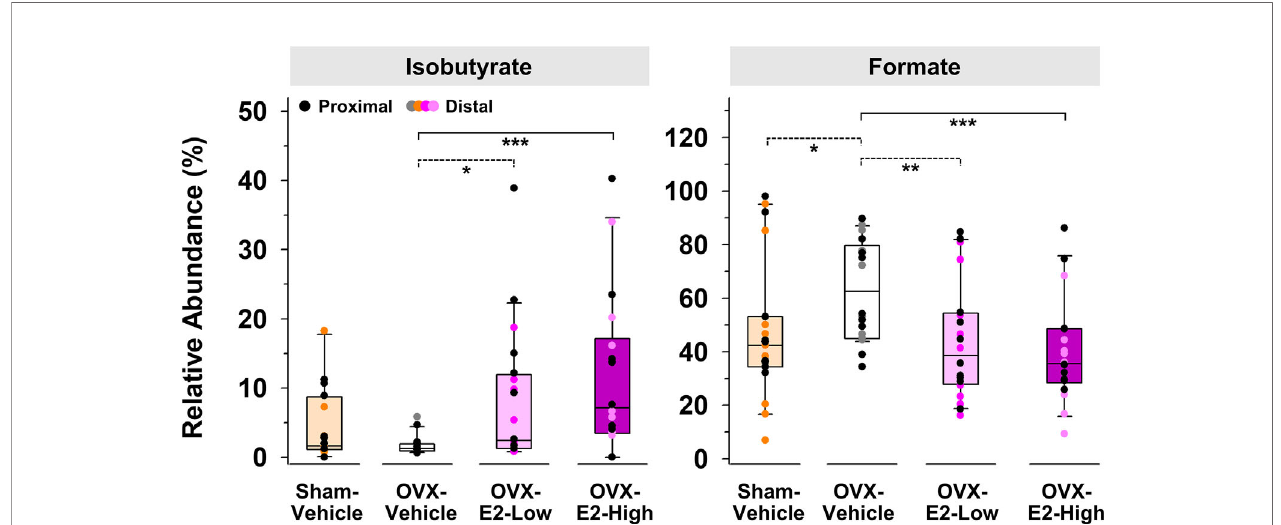
FIGURE 2 | Short-chain fatty acids that displayed a signi fi cantly (LEfSe) higher or lower relative abundance in OVX-E2-Low or OVX-E2-High rats compared to OVX- Vehicle rats. The asterisks indicate statistically signi fi cant differences (*p ≤ 0.05; **p ≤ 0.01; ***p ≤ 0.001). Solid lines between groups indicate signi fi cant q values (q ≤ 0.05). Dashed lines between groups indicate non-signi fi cant q values. Group abbreviations (e.g., Sham-Vehicle) are described in Table 1 . Error bars indicate standard